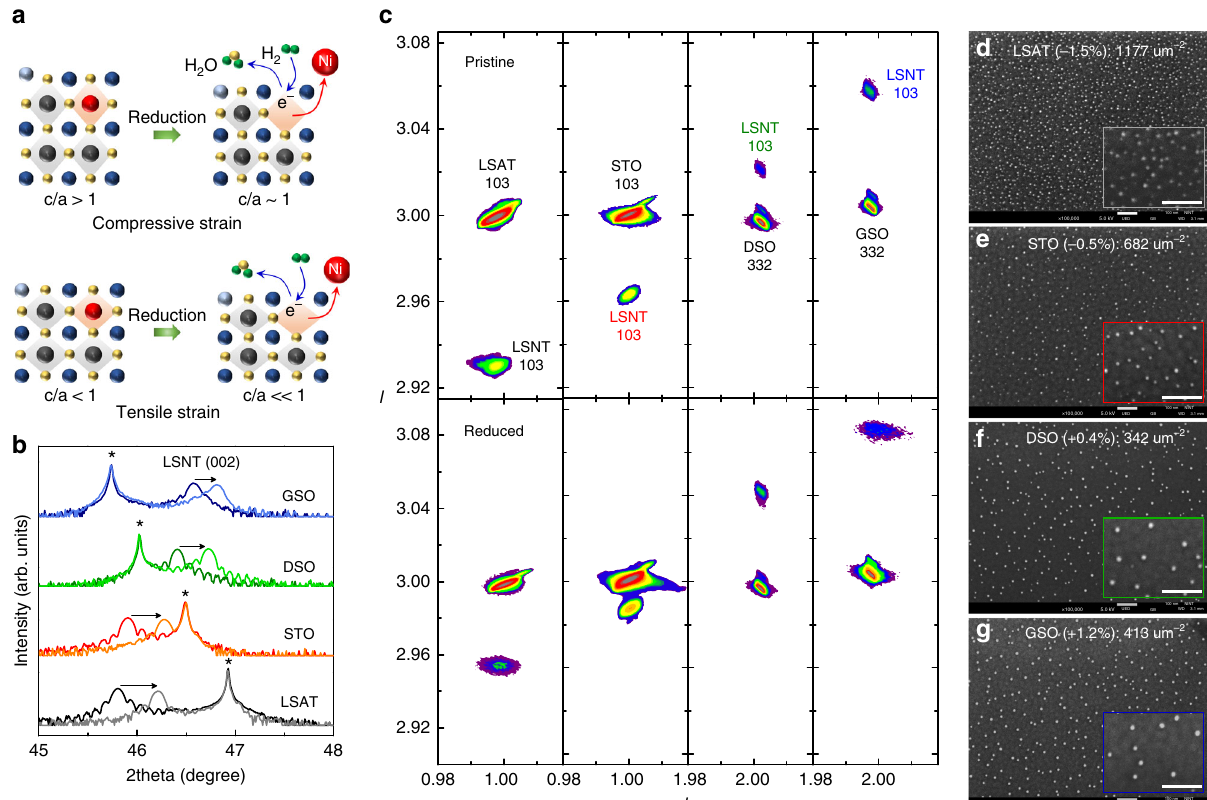
Fig. 1 Strain-enhanced exsolution in thin fi lms. a Schematic representation of the reduction process in compressive- and tensile-strained thin fi lms, where light blue circles denote La ions, blue circles denote Sr ions, red circles for Ni ions, black circles for Ti ions, yellow circles for O ions, and green circles designate H ions. b θ − 2 θ XRD patterns of pristine and reduced LSNT fi lms PLD-grown on four different substrates. c Corresponding RSM studies about 103-diffraction conditions of the pristine and reduced fi lms grown on four different substrates. SEM micrographs of the reduced (pure H 2 , 550 °C, 80 h) LSNT fi lms on d LSAT, e STO, f DSO, and g GSO substrates, respectively. Scale bars, 100